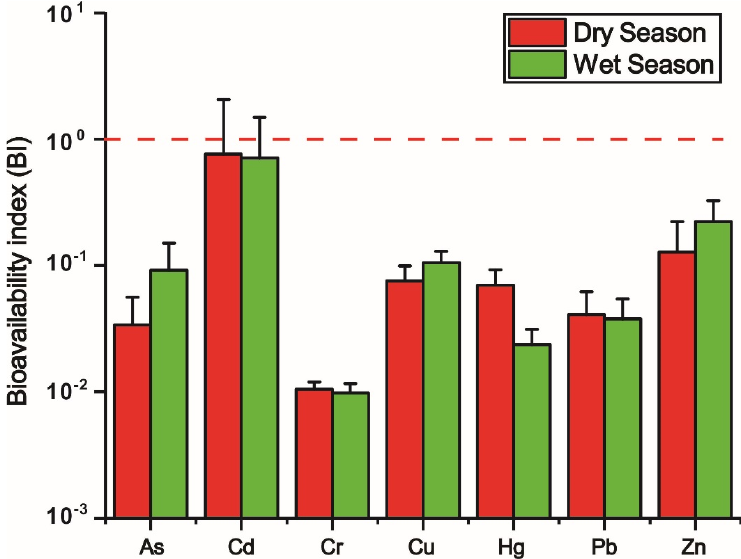
Figure 3. Bioavailability index (BI) of metals in sediments.